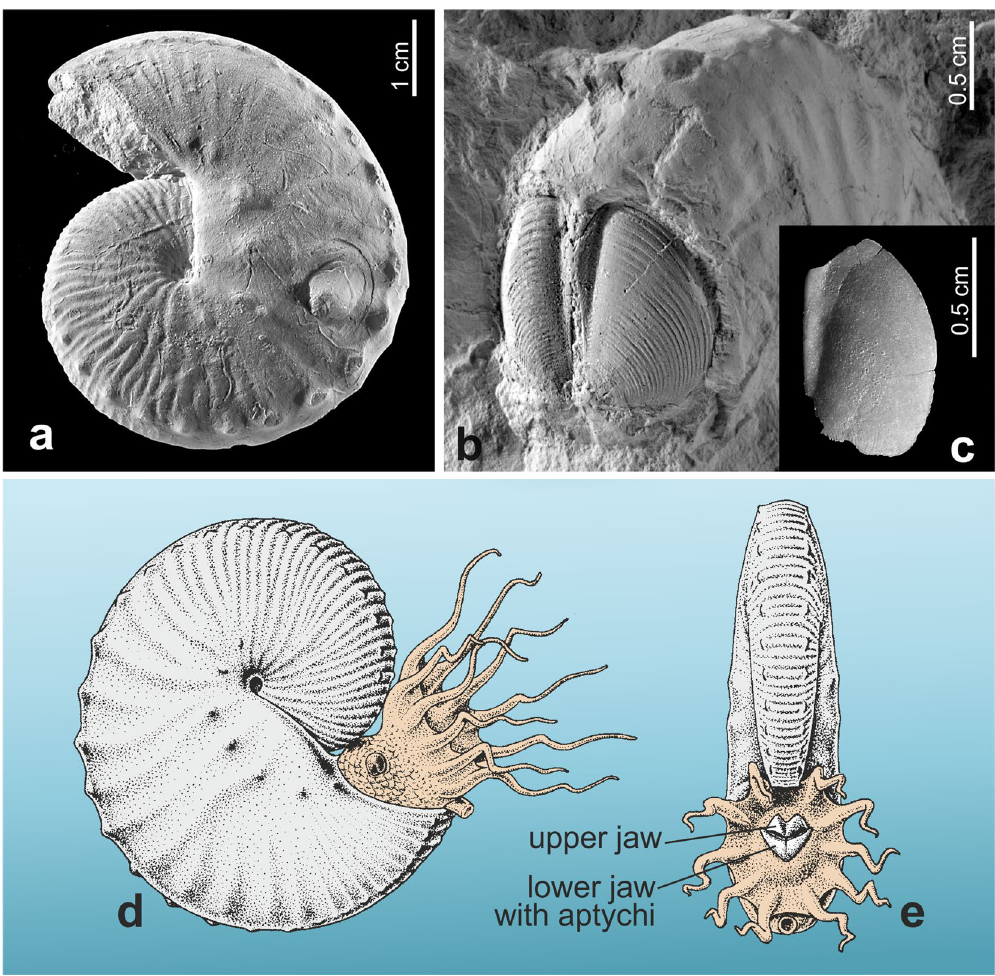
Figure 1. The scaphitid ammonoid studied. ( a ) Mould of Hoploscaphites constrictus lvivensis in lateral view (holotype of the subspecies, ZPAL Am. 12/1051). ( b ) A pair of aptychi in internal mould preservation (with discernible growth increments present on the dorsal surfaces of the original aptychi) inside a mould of H. c. lvivensis , ZPAL Am. 12/796 (see Machalski, 2021 22 for interpretation of this specimen and for terminology of aptychi). ( c ) Single aptychus, ZPAL Am. 24/104, in ventral view. ( d , e ). Speculative life restoration of the animal in lateral ( d ), and anterior ( e ), views. Specimens ( a – c ) from